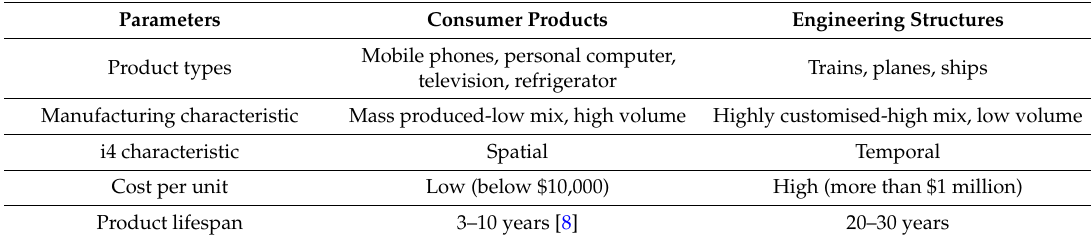
Table 1. Comparison between consumer products and engineered